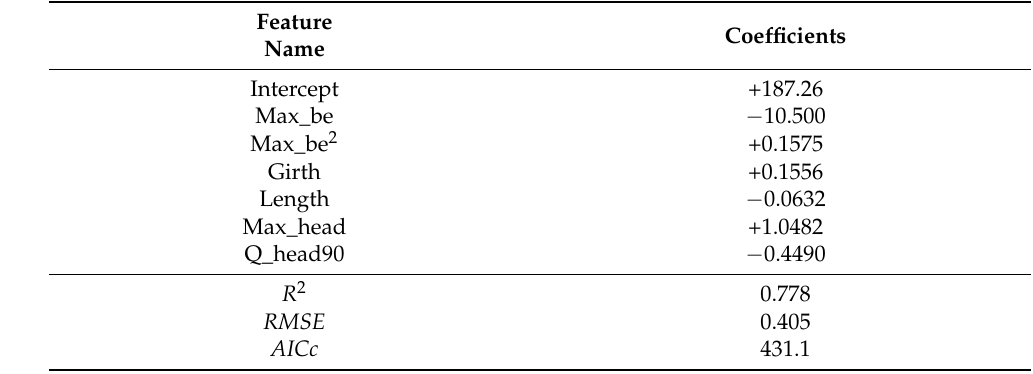
Table A1. The best multiple linear regression model of all features including chest girth and body length on rectal temperature with six features plus intercept. R 2 is the coefficient of determination, RMSE is the root mean square error, and AICc is a variation of the Akaike information criterion for small sample